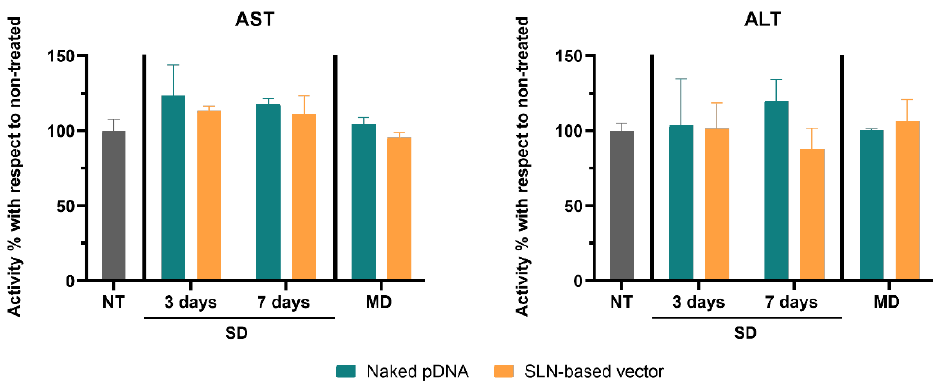
Figure 3. Aspartate Aminotransferase (AST) and Alanine Aminotransferase (ALT) activity percentage increment in livers of treated Fabry mice with respect to untreated mice, 3 and 7 days after a single administration of the naked pDNA and the SLN-based vector, and 7 days after the last administration of the multiple-dosage regimen. Data are expressed as mean ± SD ( n = 3–5 per group). NT: non-treated; SD: single dose; MD: multiple doses; pDNA: plasmid DNA; SLN: solid lipid nanoparticle.